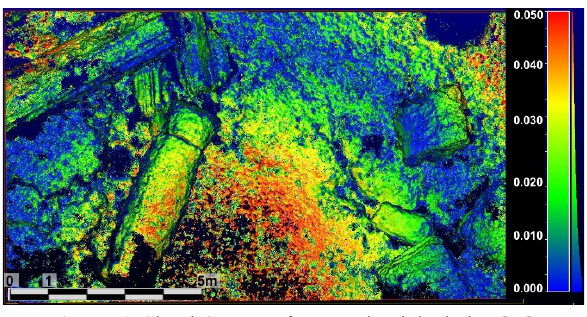
Figure 6. Cloud G7a to reference cloud deviation [m].